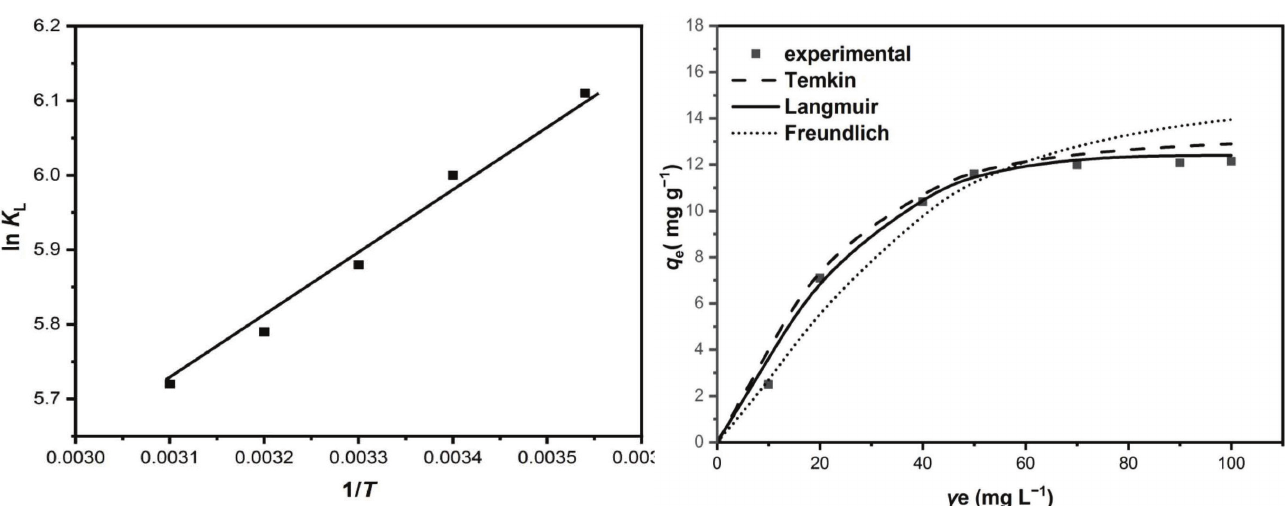
Fig. 3 – Van’t Hoff plot of SR 3BL dye adsorption onto Oxalis (experimental conditions: adsorbent dose 1 g L −1 , pH 6, initial dye concentration 50 mg L –1 , contact time 35 min, temperature 25 °C, volume of dye solution 50 mL, agitation speed 200 rpm)